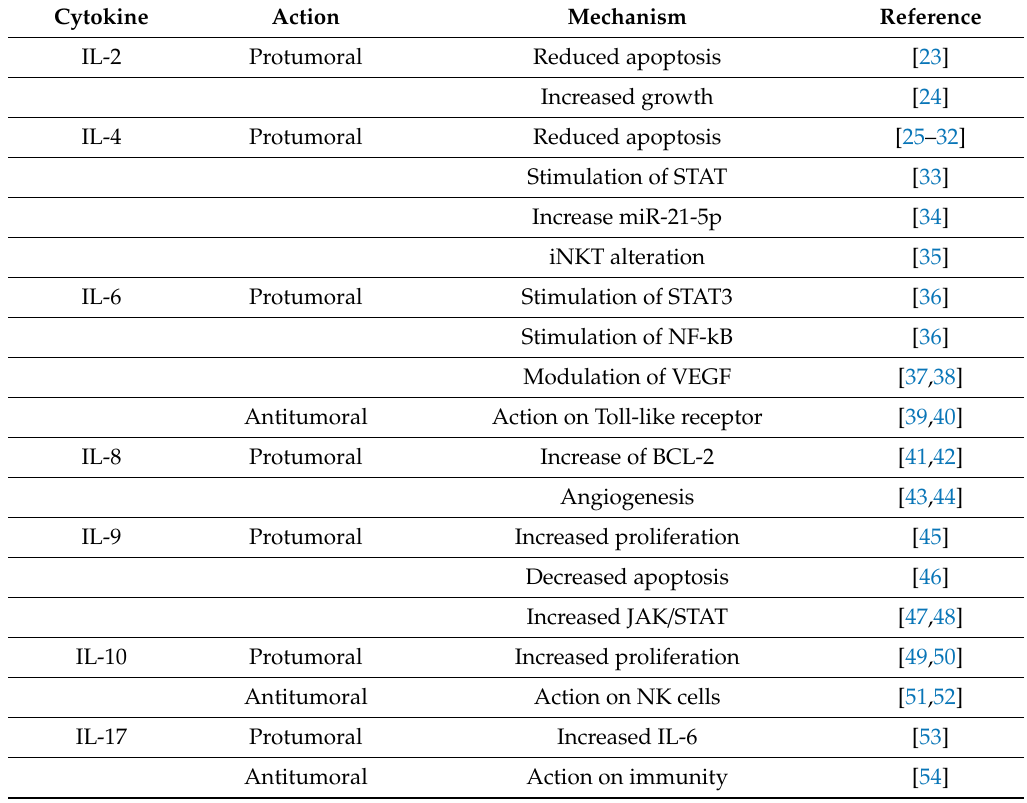
Table 1. E ff ects of cytokines on the cellular dynamics of B-cell lymphocytic leukemia (B-CLL).